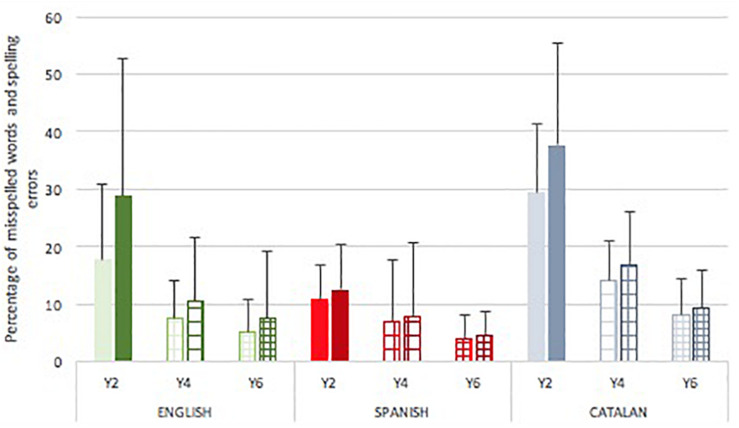
Mean (SD) percentage of misspelled words (left column) and spelling errors (right column) by language and school grade.